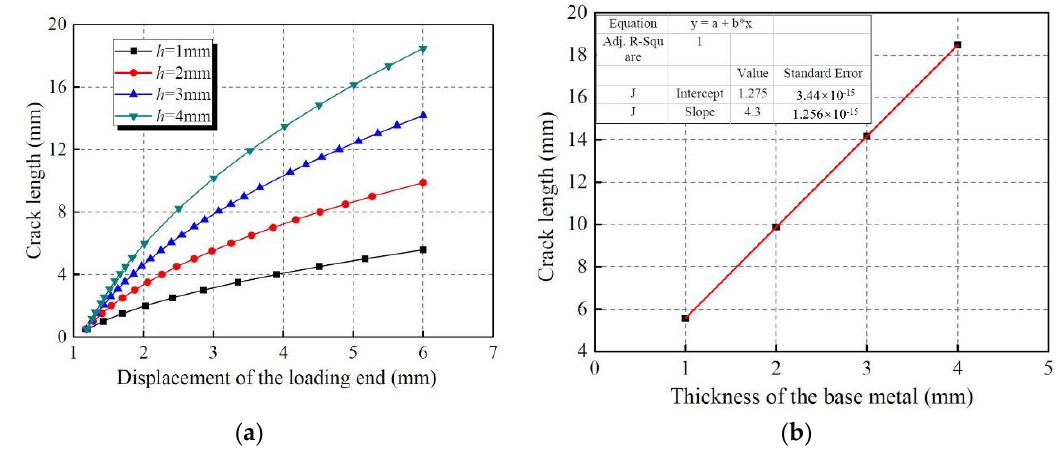
Figure 19. ( a ) Effect of base metal thickness on crack length; ( b ) Fitting relationship between crack length and base metal